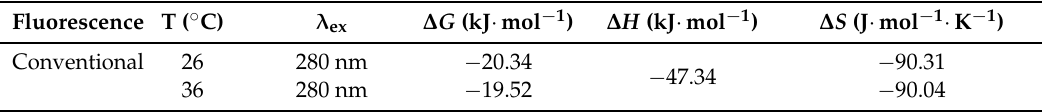
Table 4. Thermodynamic parameters of SSC-HSA